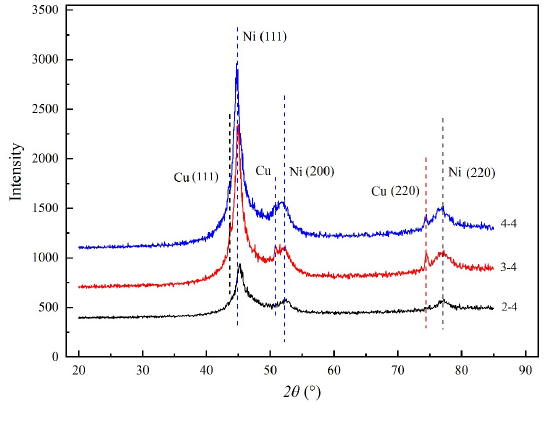
Table 9. Integral breadth values and calculated values of the crystallite size of the (111) nickel peak as a function of the number of depositions.